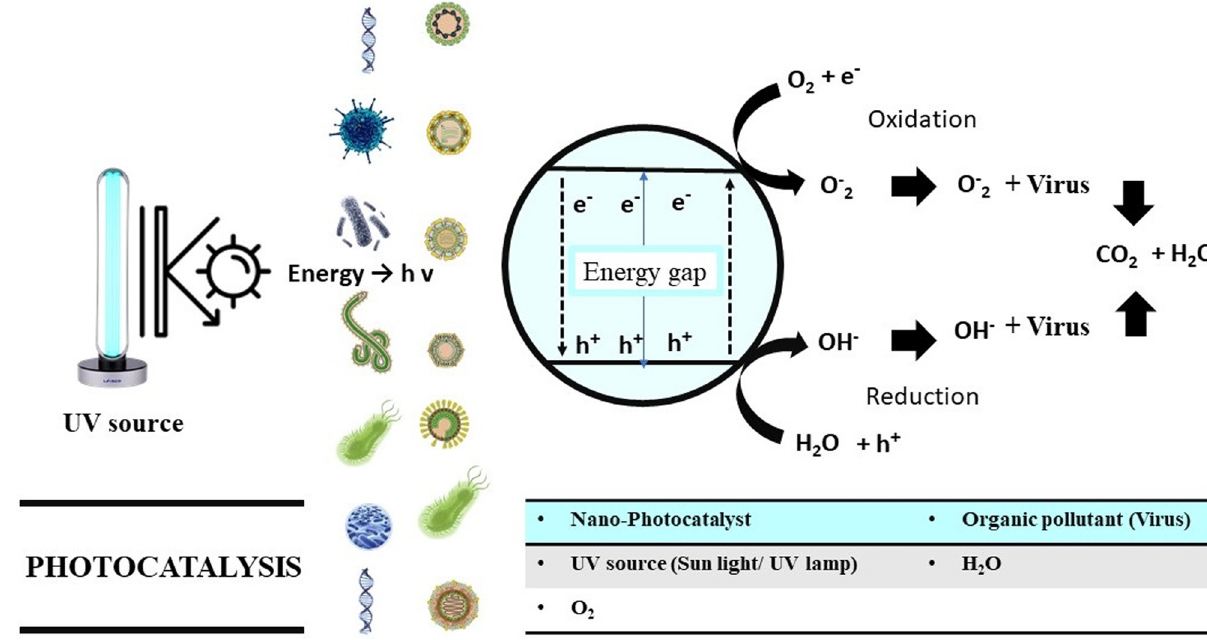
Figure 13: Degradation of CoV in wastewater by